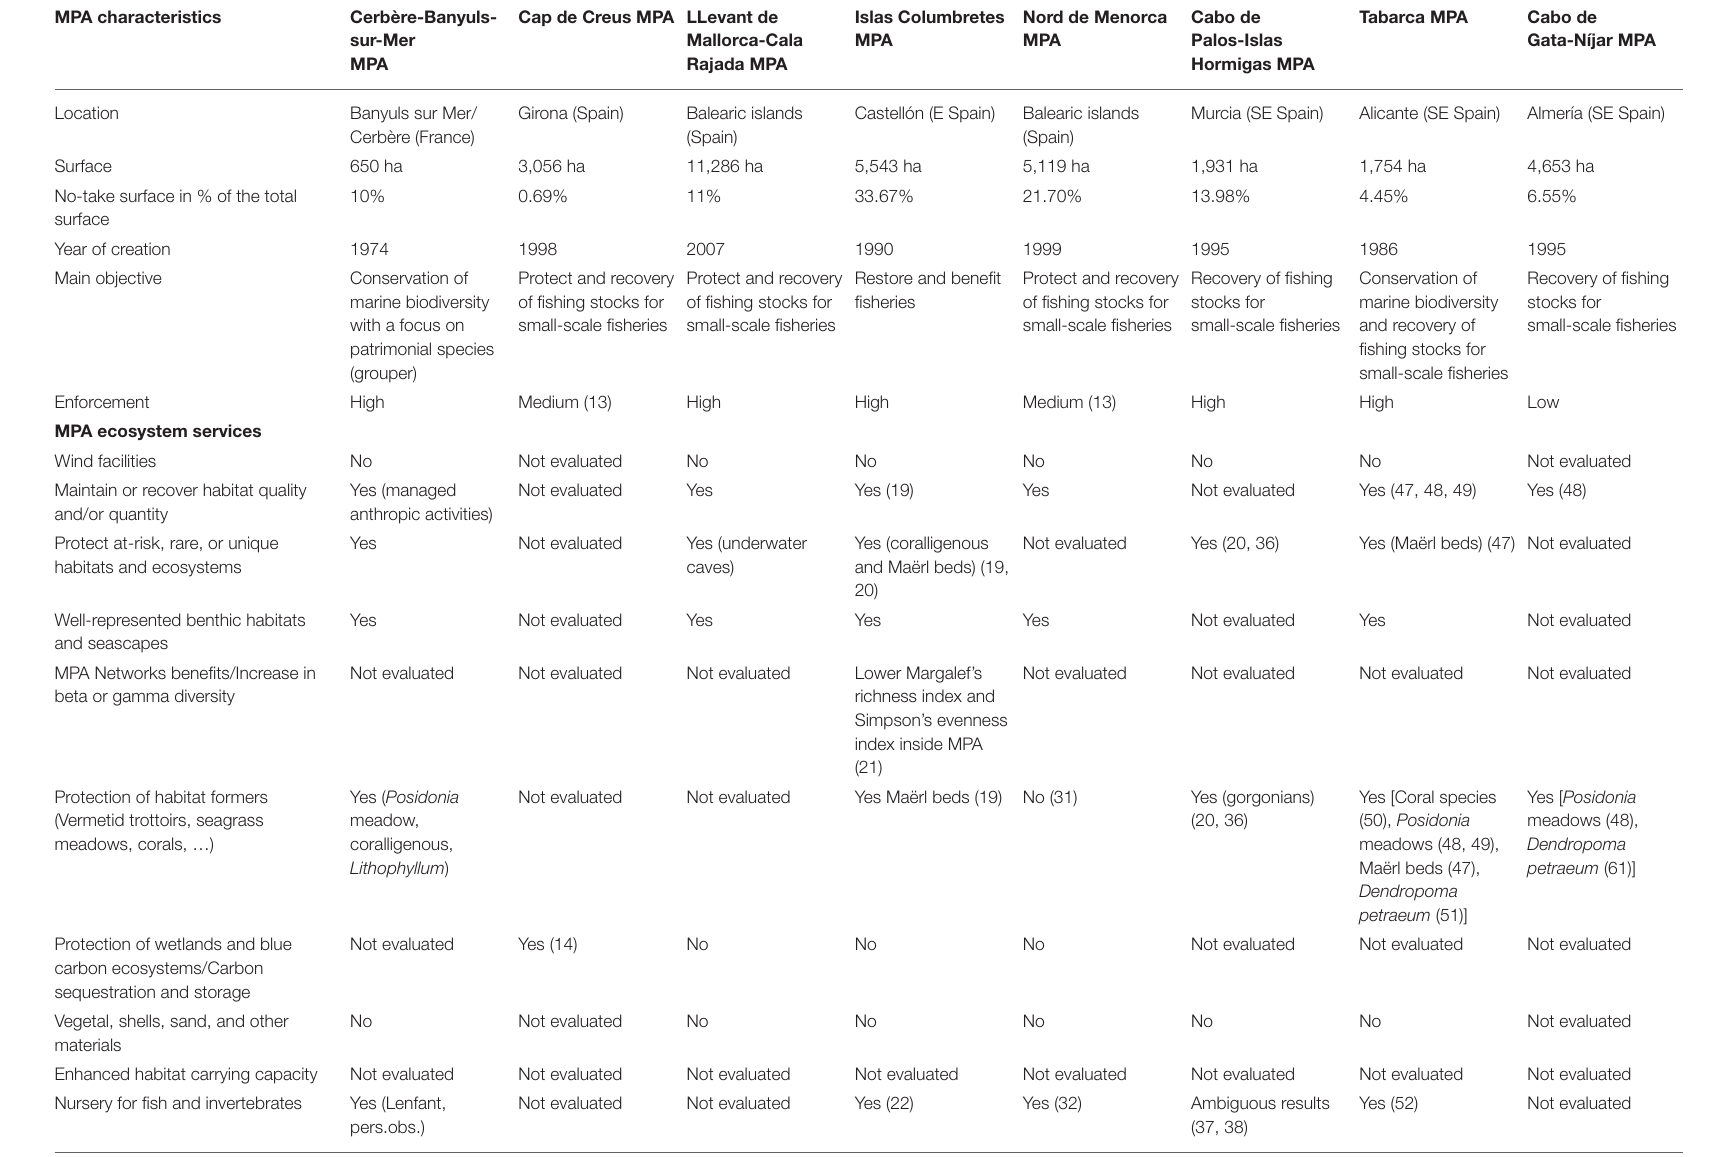
TABLE 2 | Attributes, processes, ecosystem services, and societal benefits associated with Marine Protected Areas in eight MPAs in the western